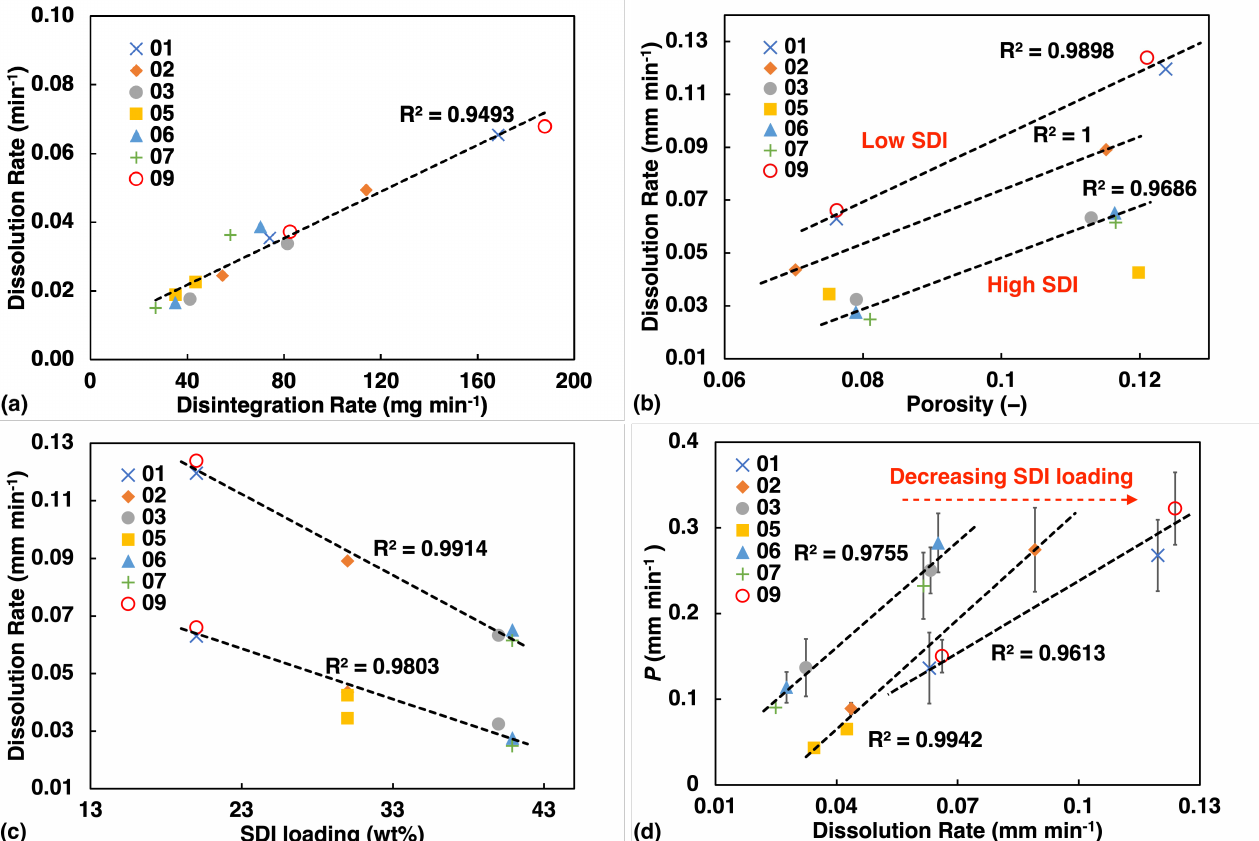
Figure 6. USP test results ( a ) Disintegration test showing high linearity with dissolution rate. ( b ) Dissolution test: rate constant from fitting the dissolution curve, plotted against porosity. ( c ) Dissolution rate plotted against SDI loading. ( d ) Correlation between the water ingress rate constant k and the dissolution rate from the